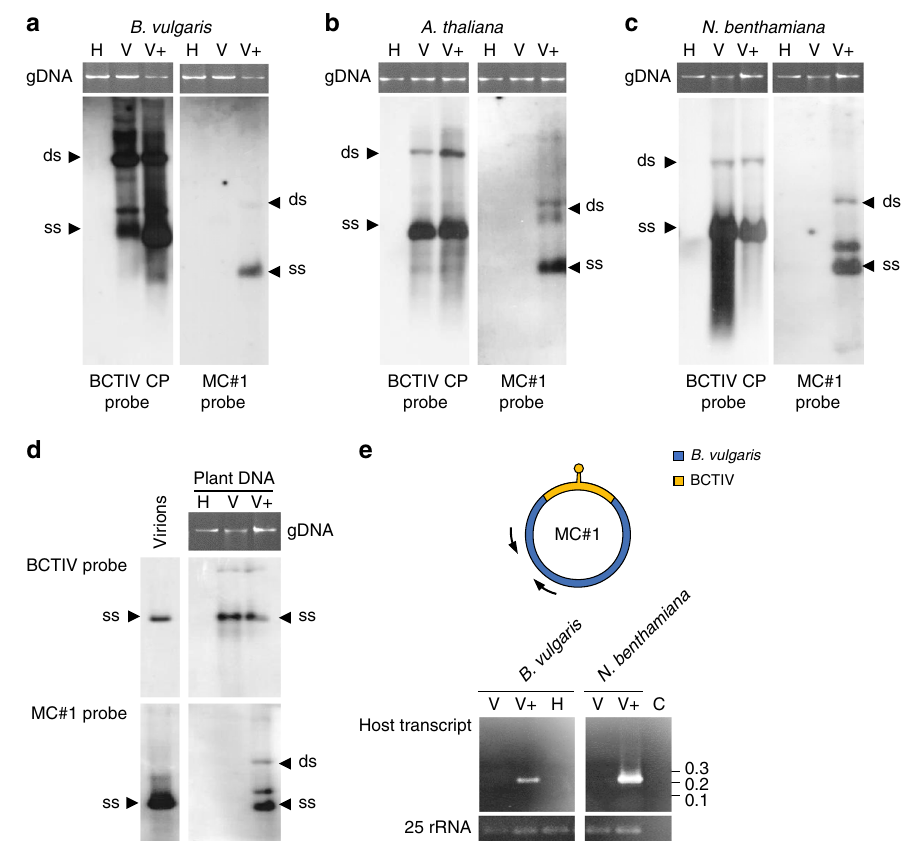
Fig. 3 MC#1 replication and transcription when transfected to various hosts. Southern blots of DNA extracted from B. vulgaris ( a ), A. thaliana ( b ) and N. benthamiana ( c ), mock-inoculated healthy plants (H); plants agroinfected with BCTIV (V) or with both BCTIV and MC#1 (V + ). Leaves were collected at 4 weeks post inoculation (wpi) and hybridized with BCTIV- or MC#1-speci fi c probes (see Fig. 1b). Bands of single and double stranded DNAs are indicated as “ ss ” and “ ds ” , respectively. Plant genomic DNA (gDNA) is shown above the blots as a loading control. Source data are provided as Supplementary Data 5. d Southern blot of DNA extracted from puri fi ed BCTIV virions and from the N. benthamiana plants used for puri fi cation of BCTIV particles, hybridized with the BCTIV- and the MC#1-speci fi c probes (see Fig. 1b). “ ss ” , “ ds ” and gDNA as in a – c . Source data are provided as Supplementary Data 5. e Transcription of the beet-derived DNA sequence of MC#1 in B. vulgaris and N. benthamiana plants inoculated with BCTIV and MC#1 (V + ) detected by RT- PCR with primers positioned as indicated by arrows in the upper part of the panel. Lanes are marked H, V and V + as in a – d , whereas C is a RT-PCR- negative reaction control. Source data are provided as Supplementary Data